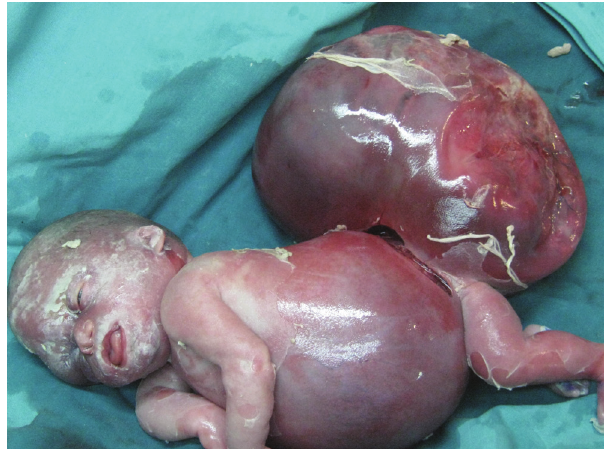
Figure 1 - A view of the huge SCT and the fetus showing hydrops fetalis.